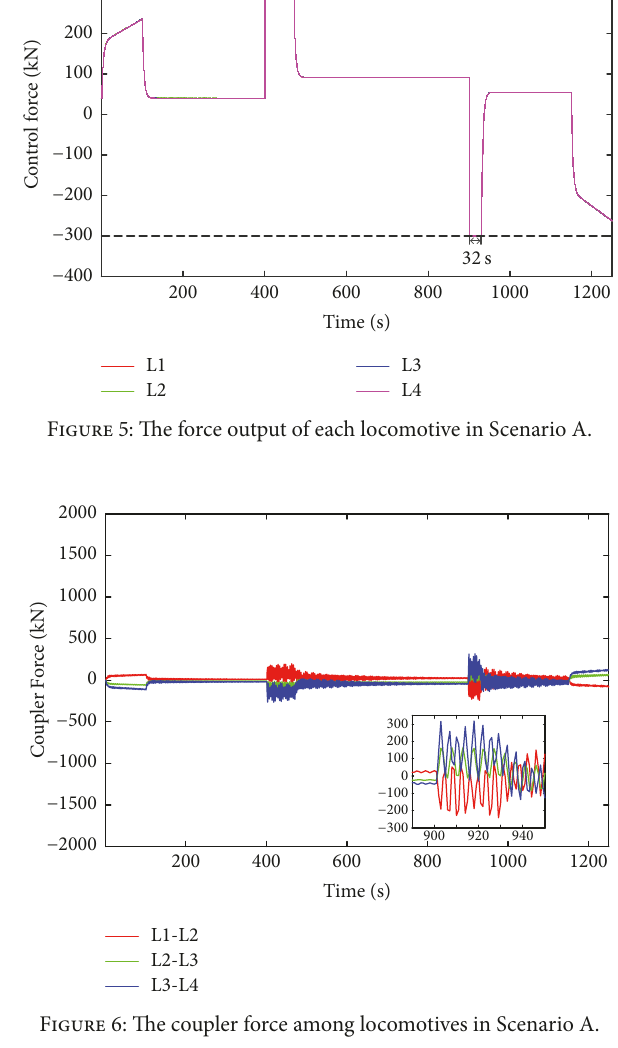
the effectiveness of the proposed strategy.